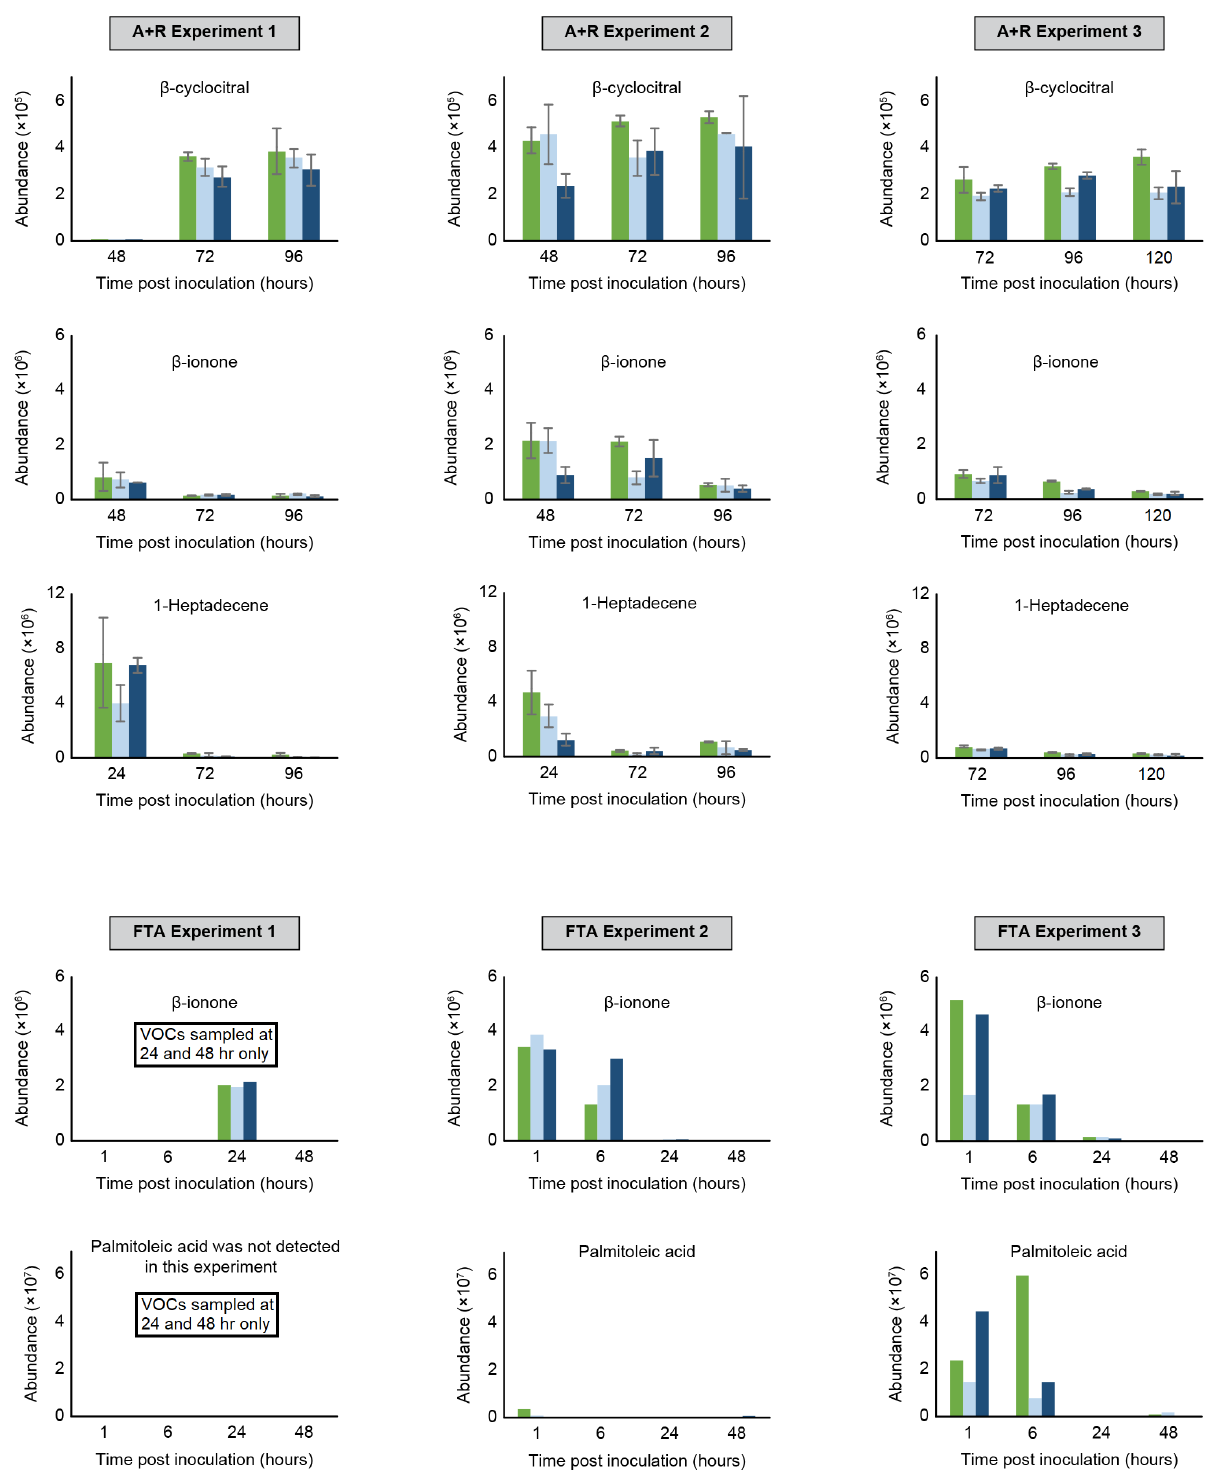
Figure 3. Peak areas of extracted ion chromatograms for β -cyclocitral, β -ionone, and 1-heptadecane in each A + R replicate experiment (top nine graphs) and for β -ionone and palmitoleic acid in each FTA replicate experiment (bottom six graphs). Error bars in A + R experiments represent standard deviation of technical replicates for each sample. Semi-quantitative VOC analysis for the same putative biomarker was set relative to the highest intensity across all three replicate experiments. For comparison across A + R and FTA experiments, relative abundance scale for β -ionone was set relative to the observed highest peak area in FTA Experiment 3.